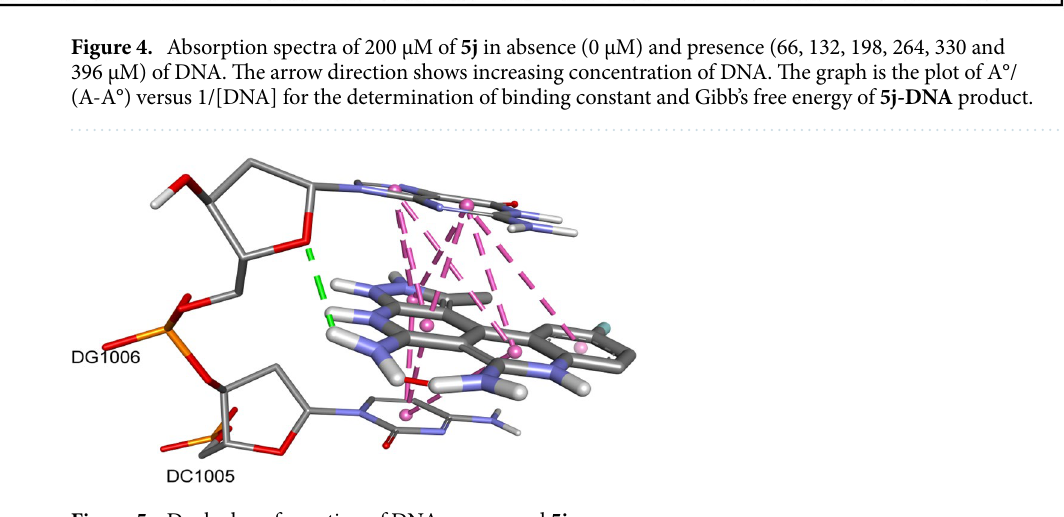
Figure 5. Docked conformation of DNA, compound 5j